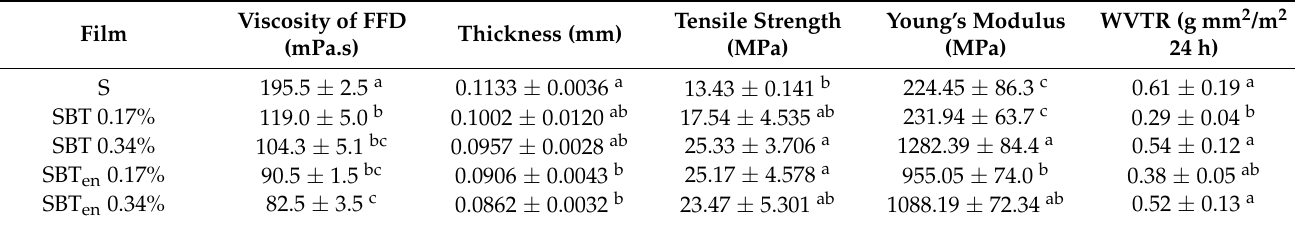
Table 1. Viscosity of FFD, thickness, mechanical properties, and water vapor transmission rates (WVTR) of starch films incorporating free or encapsulated SBT extracts.